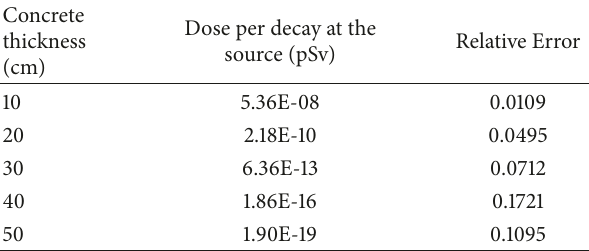
Table 3: MCNP simulation